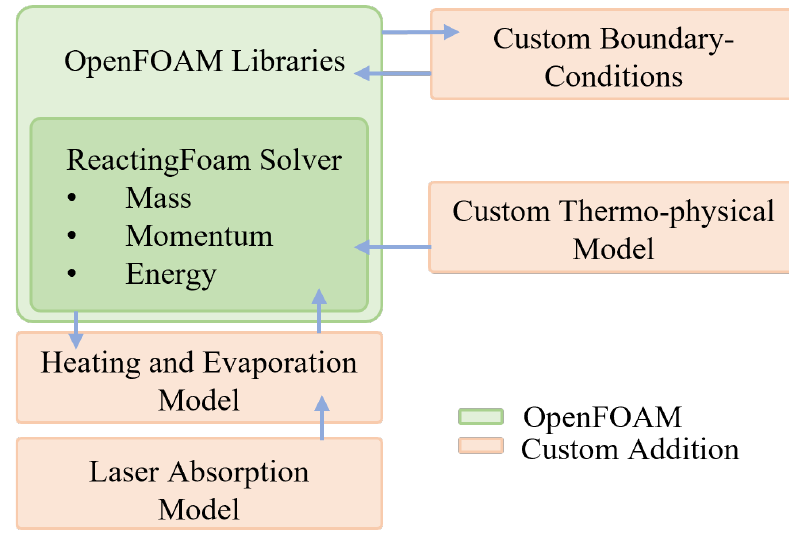
Figure 3. Block scheme of the numerical solver built in